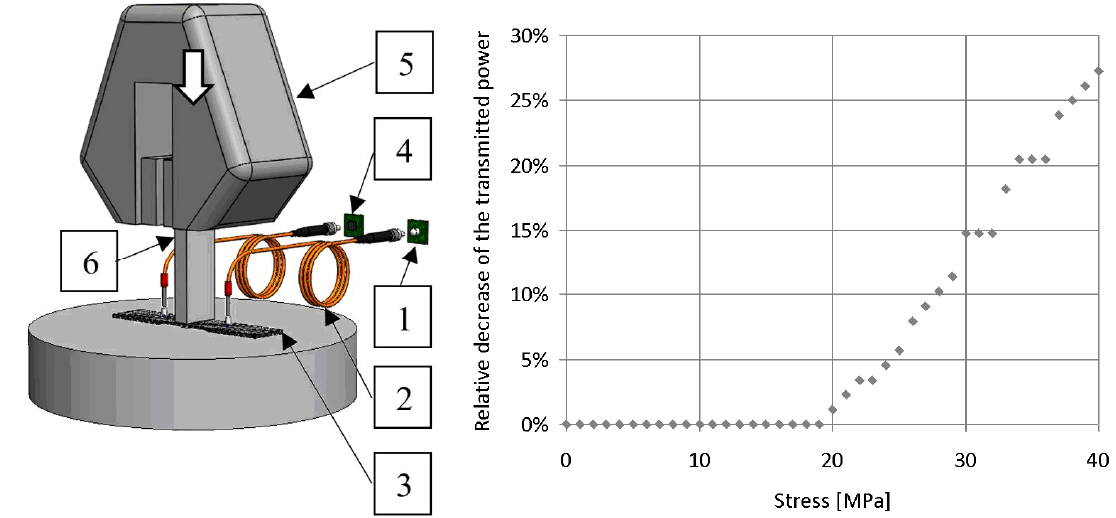
Figure 4. Compression measurement layout (1: light source, 2: signal transmitter (polymer optical fibre), 3: specimen, 4: photodiode, 5: clamp of the tensile tester, 6: compression fixture) and a typical plot.